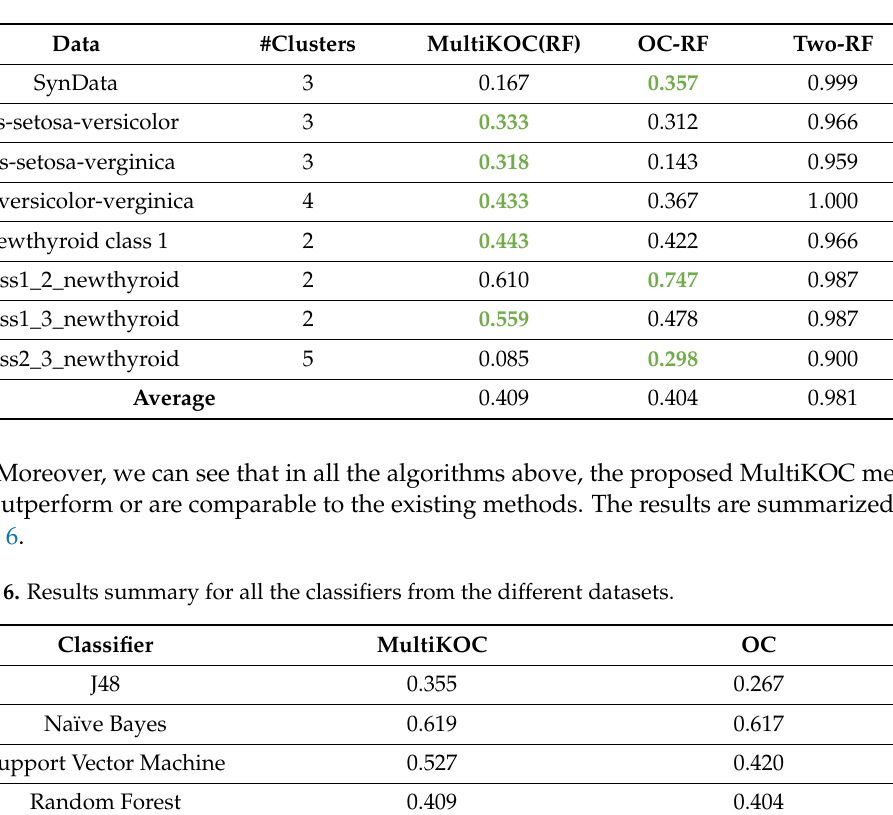
Table 5. Results summary for Random Forest classifier. The column #clusters is the optimal number of clusters obtained for MultiKOC.